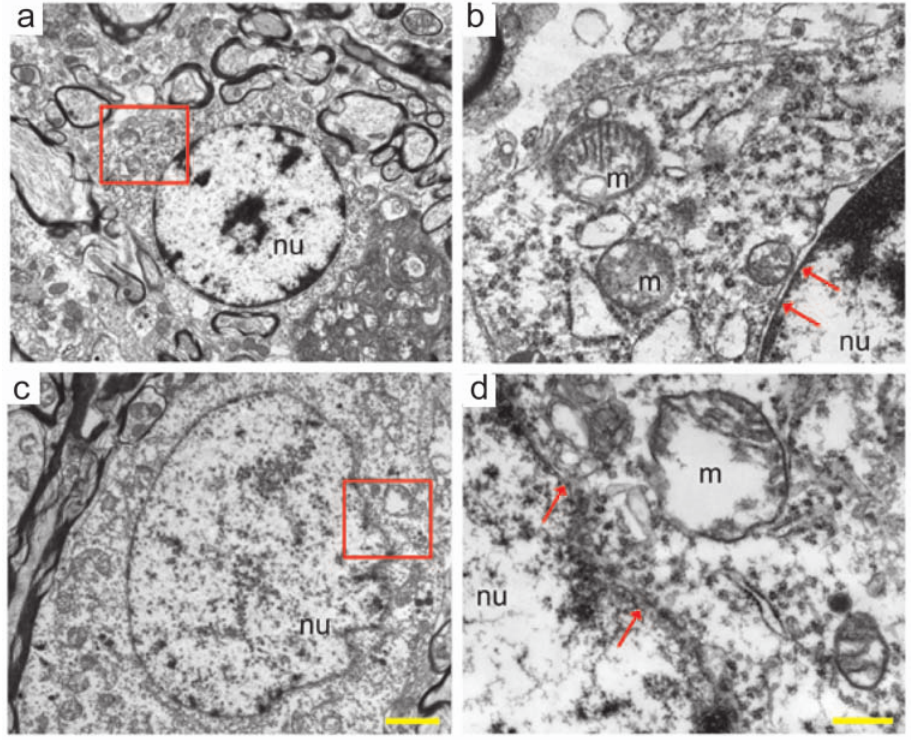
Figure 5. Necrotic cell death accounts for the loss of functional integrity in RVLM. Representative electron photomicrographs showing ultrastructure of RVLM neurons from sham-control animals (a and b) or animals that received intravenous administration of a lethal dose of Mev (1280 m g/kg) (c and d). Panels c and e represent enlargement of areas denoted in a and c. Note intact (b) and disrupted (d) nuclear membrane integrity (arrows); normal (a) and enlarged nucleus (nu) with nuclear electron-lucency (c); and intact (b) and swollen mitochondria (m) with disarrayed cristae (d). These results are typical of 4 animals from each experimental group. Scale bars: 2 m m in a and c; 0.5 m m in b and d.